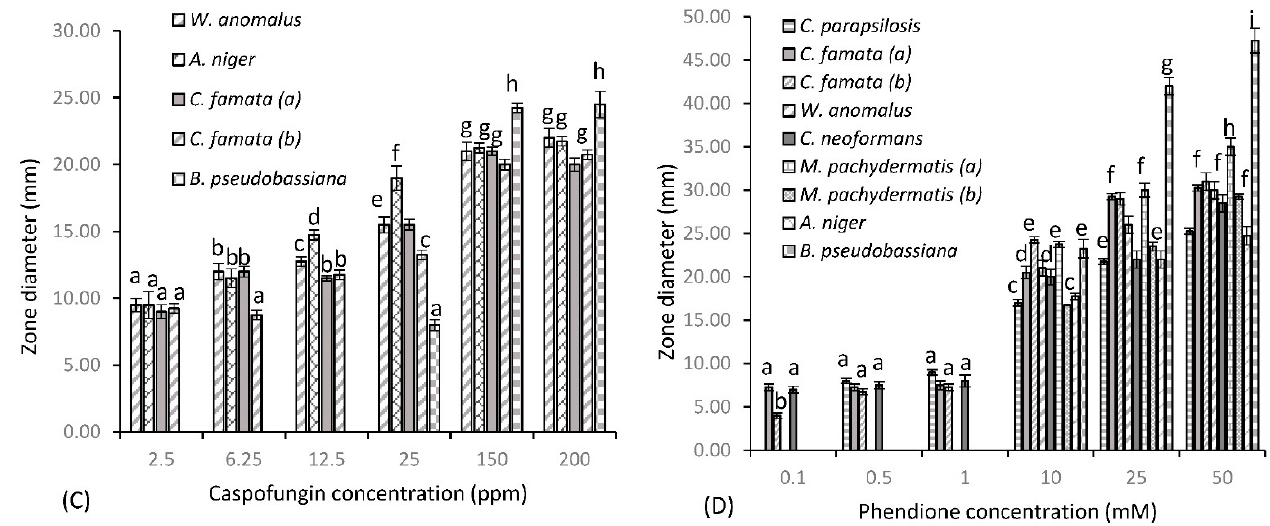
Figure 1. Zones of diameter (mm) for fungal dermal isolates of canine disease for ( A ) fluconazole, ( B ) AMP B, ( C ) caspofungin and ( D ) test agent phendione (±S.D). Alphabetical letters denote significant difference at p < 0.05.